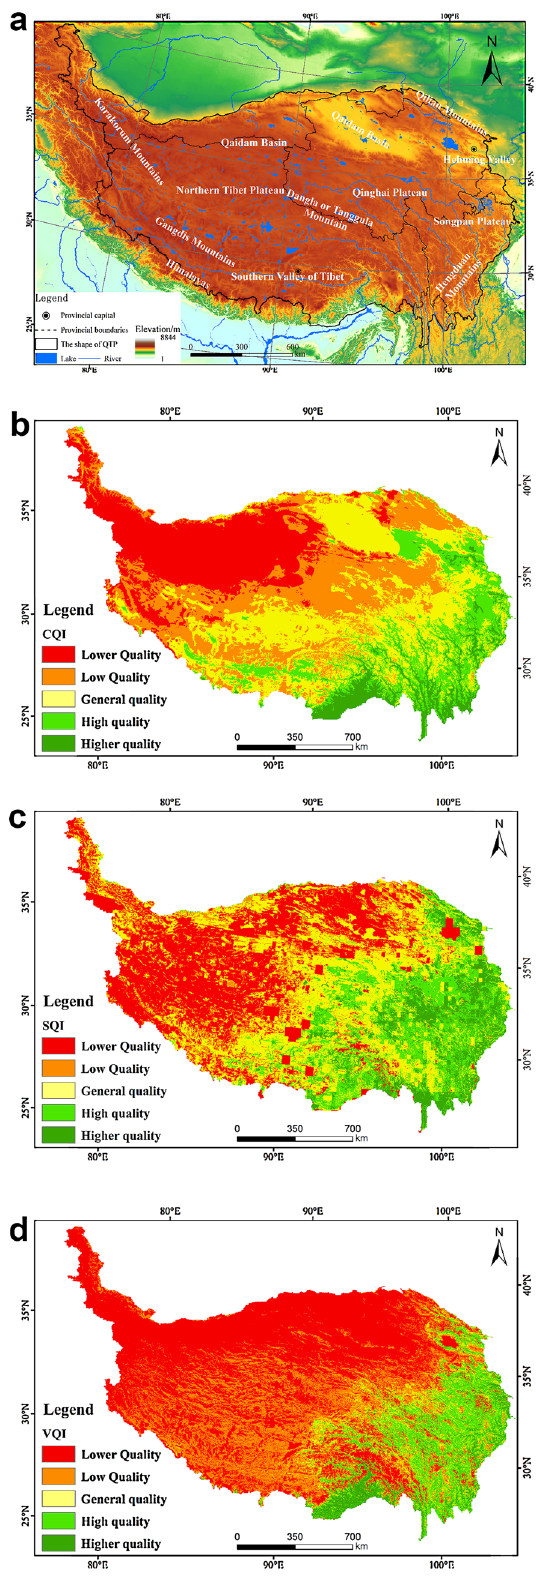
Figure 1. ( a ) Location of DEM over the QTP. The map was generated by ArcGIS sofware (Version 10.5 for Desktop). ( b ) The climate quality of the QTP. The map was generated by ArcGIS sofware (Version 10.5 for Desktop) for Desktop). ( c ) The soil quality of QTP. The map was generated by ArcGIS sofware (Version 10.5 for Desktop). ( d ) The vegetation quality of the QTP. The map was generated by ArcGIS sofware (Version 10.5 for